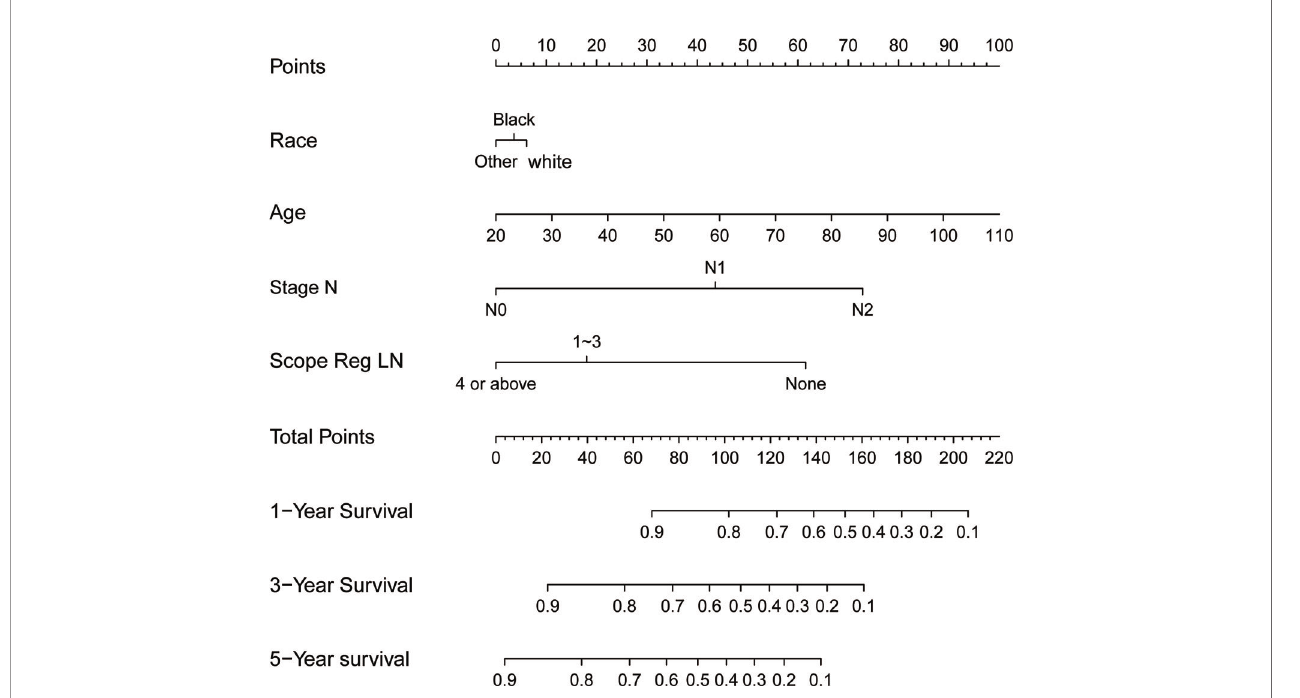
FIGURE 5 | Nomograms for overall postoperative survival of T2 gallbladder